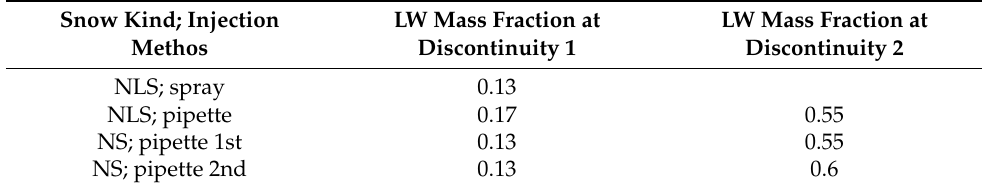
Table 3. LW mass fraction at the c discontinuities.